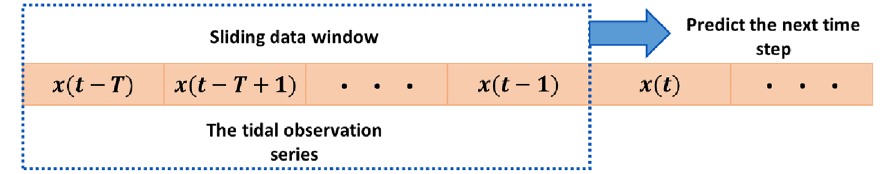
Figure 2. Schematic diagram of the sliding data